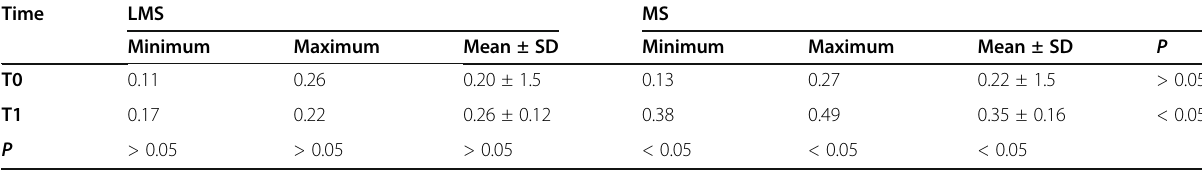
Table 2 Comparison of the mean value of PICF ( μ l) detected in the LMS and MS groups